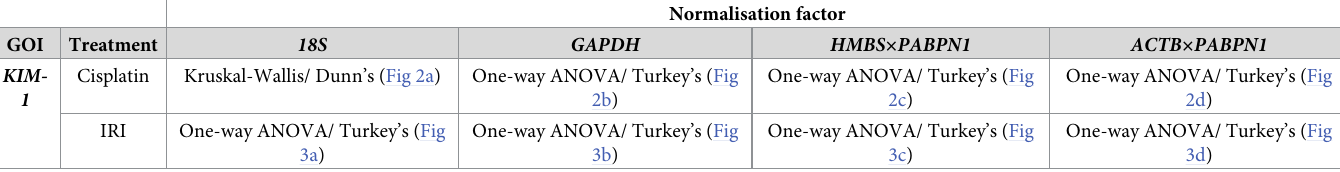
Table 7. Statistical methods used to analyse KIM-1 gene expression.